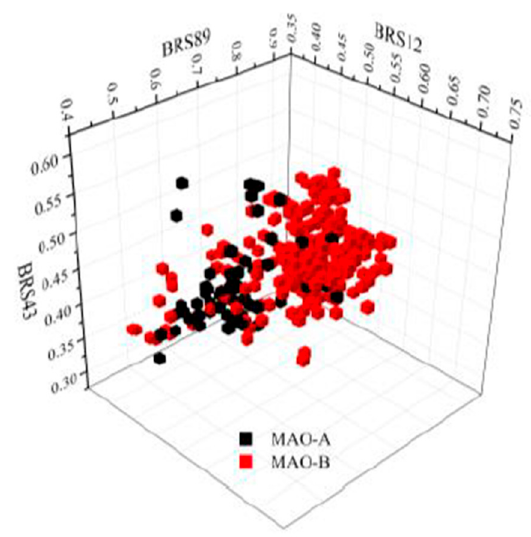
Figure 2. The distribution of selective MAO inhibitors on the basis of three BRS-3D features (BRS12: 1cbq_RE9, BRS43: 3i8u_18B; BRS89: 1vj5_CIU).